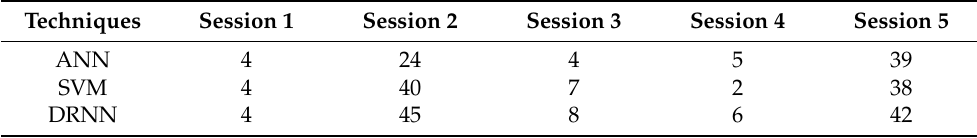
Table 4. Mood, health, and stress prediction outcomes of existing and proposed classification